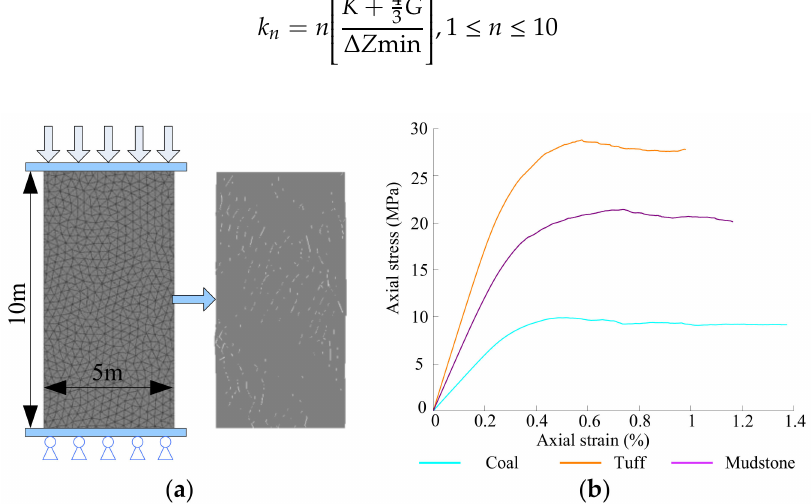
Figure 9. Results of simulated uniaxial compression test for the rock mass: ( a ) numerical uniaxial compression test; ( b ) optimal stress–strain curve.